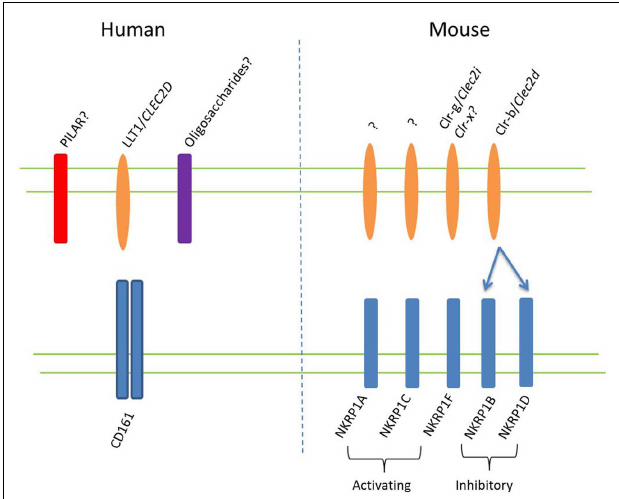
FIGURE 2 | NKRP1 ligands in mouse and man. Putative ligands for CD161, expressed on humanT lymphocytes, are shown on the left side of the figure.The CD161 ortholog in mice exists as a family of genes, known as NKRP1 receptors, which are thought to consist of at least three activating and two inhibitory receptors, as shown on the right.The ligands for these receptors are Clr proteins, with the two known ligands depicted. A recent study suggested that NKRP1F may also recognize Clr-x (Aust et al.,